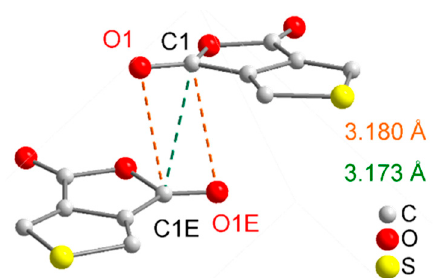
Figure 7. Electrostatic C ··· O interactions of 7 , that occur between both interpenetrating networks, shown in Figure 6.